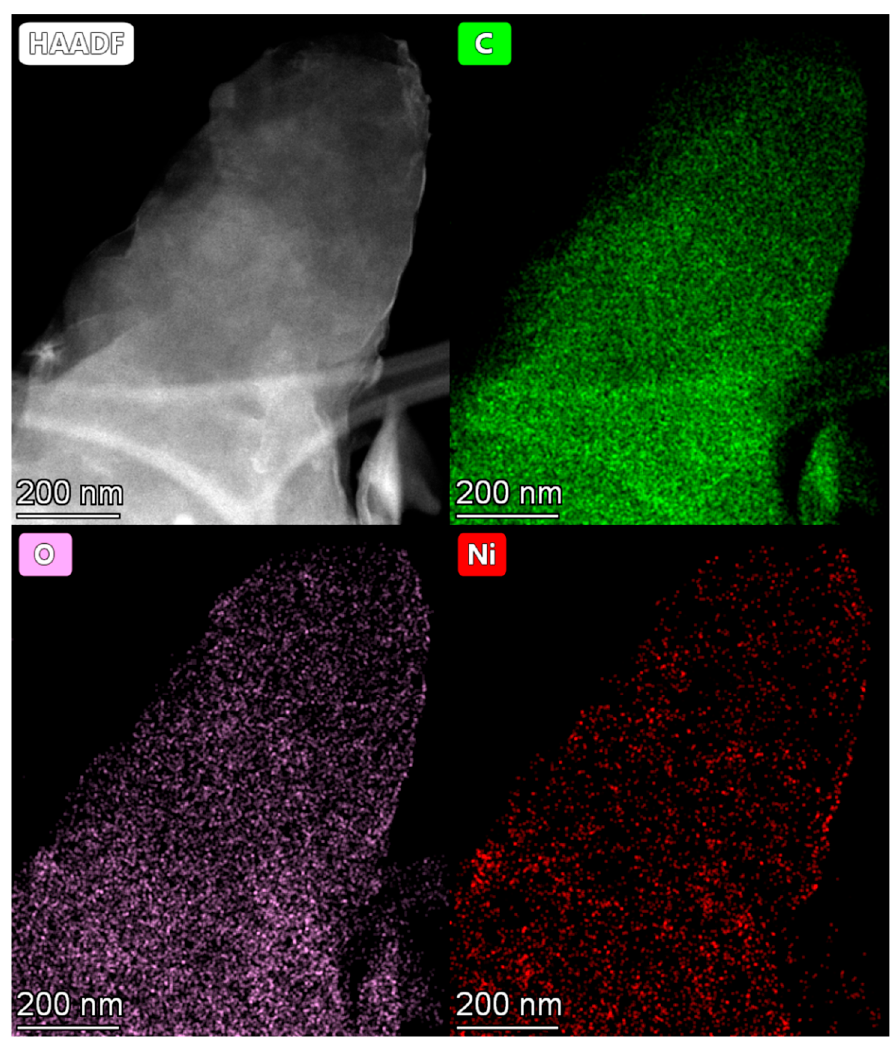
Figure 4. The EDX mapping of the area shown in Figure 3b.